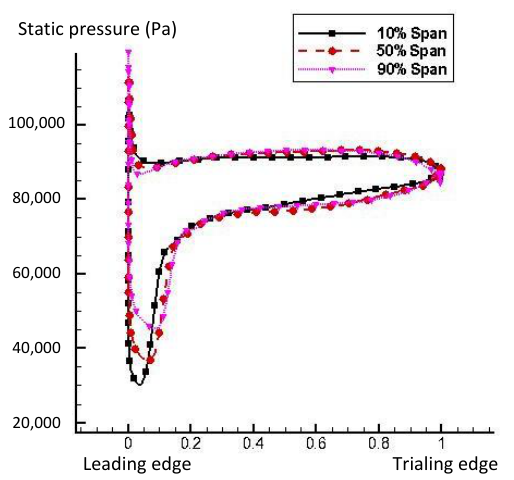
Figure 10. Blade Loading of Air-driven Fan at Different Span (0% for hub and 100% for shroud).